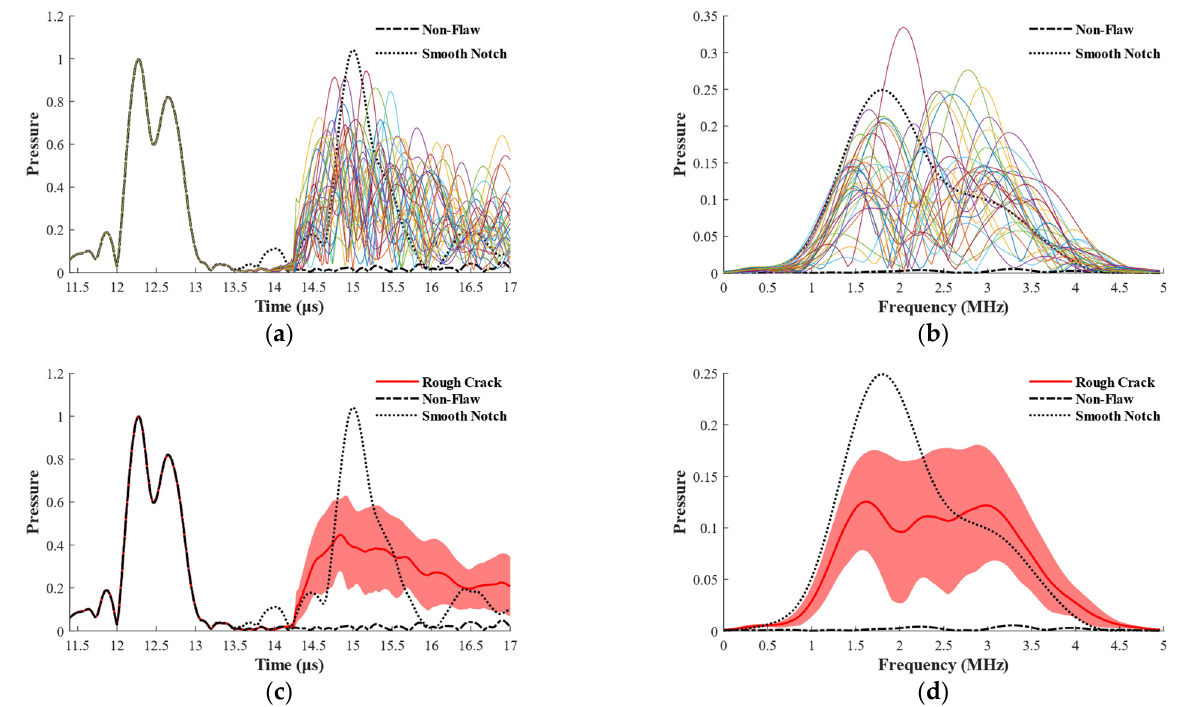
Figure 9. The flaw echoes from the rough crack in time and frequency domain. ( a ) Multiple repetitions in time domain; ( b ) multiple repetitions in frequency domain; ( c ) statistical results in time domain; ( d ) statistical results in frequency domain. The width of the notch was 0.02 mm.